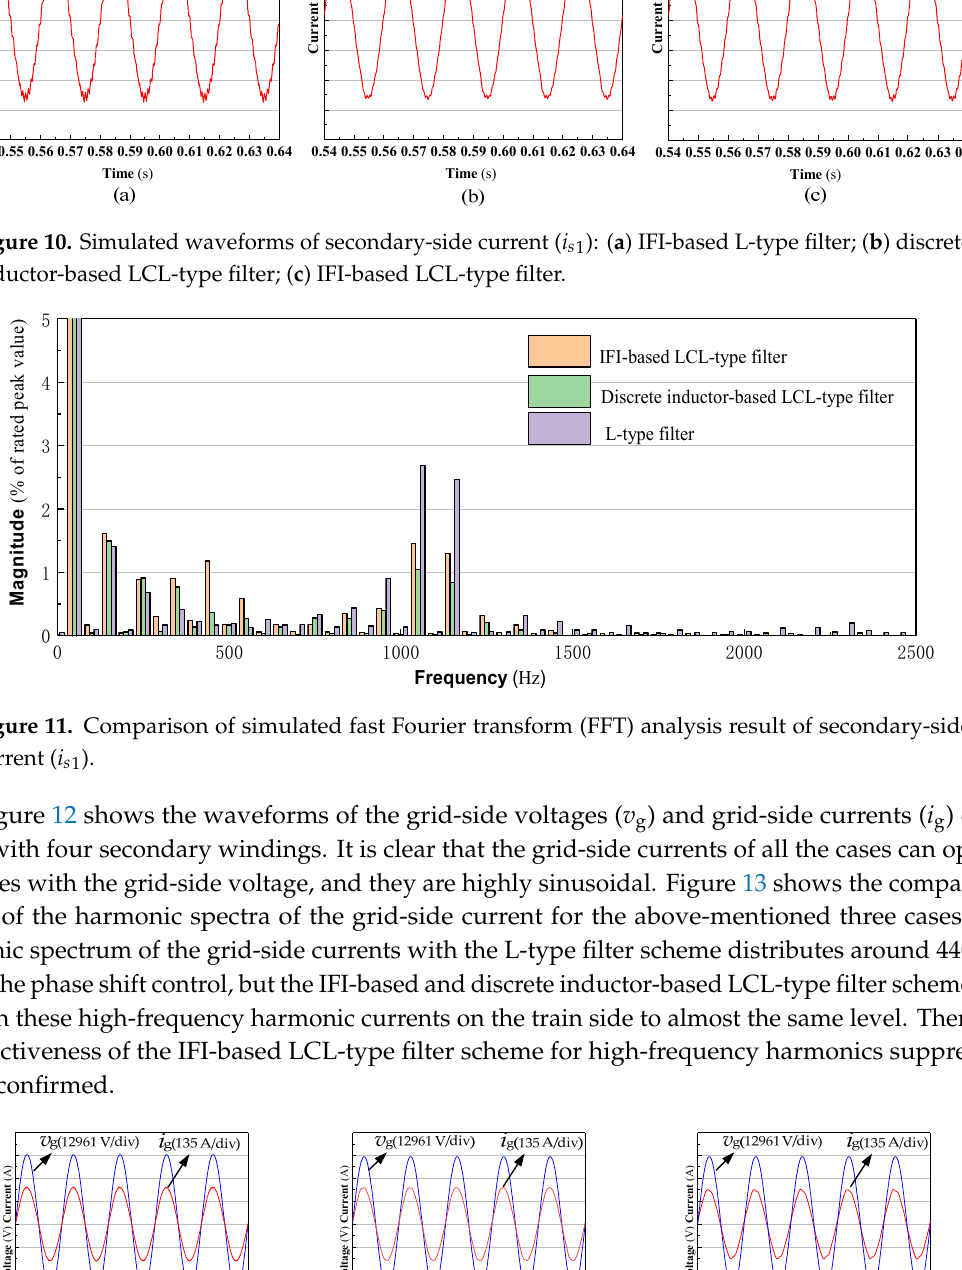
Figure 12. Simulated waveforms of grid voltage ( v g ) and grid current ( i g ) for: ( a ) IFI-based L-type filter; ( b ) discrete inductor-based LCL-type filter; and ( c ) IFI-based LCL-type filter.